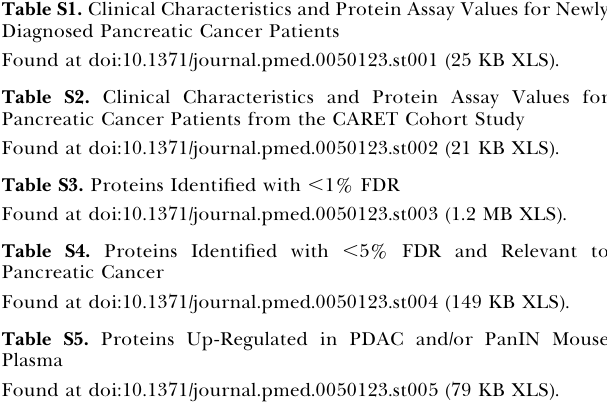
Figure S4. Box Plot for ELISA Measurements of Proteins Relevant to Pancreatic Cancer A total of 30 human PDAC sera (20 sera for TNFRSF1A and WFDC2), 20 healthy, and ten chronic pancreatitis (15 sera for TIMP1 and ALCAM) were assayed for the plotted proteins. More statistical detail about this data is presented in Table 2. The horizontal axis legend represents: 1, cancer; 2, normal; 3, pancreatitis. Figure S5. Receiver Operating Characteristic Curves for ELISA Measurements of Proteins Relevant to Pancreatic Cancer All data points for each individual protein were used in the Receiver Operating Characteristic (ROC) plots, without applying any cut-off value. The total number of samples used in this analysis was: 30 human PDAC sera (20 sera for TNFRSF1A and WFDC2), 20 healthy, and ten chronic pancreatitis (15 sera for TIMP1 and ALCAM). Detailed statistical information for these proteins is presented in Table 2. Table S1. Clinical Characteristics and Protein Assay Values for Newly Diagnosed Pancreatic Cancer Patients Found at doi:10.1371/journal.pmed.0050123.st001 (25 KB XLS). Table S2. Clinical Characteristics and Protein Assay Values for Pancreatic Cancer Patients from the CARET Cohort Study Found at doi:10.1371/journal.pmed.0050123.st002 (21 KB XLS). Table S3. Proteins Identified with , 1% FDR Found at doi:10.1371/journal.pmed.0050123.st003 (1.2 MB XLS). Table S4. Proteins Identified with , 5% FDR and Relevant to Pancreatic Cancer Found at doi:10.1371/journal.pmed.0050123.st004 (149 KB XLS). Table S5. Proteins Up-Regulated in PDAC and/or PanIN Mouse Plasma Found at doi:10.1371/journal.pmed.0050123.st005 (79 KB